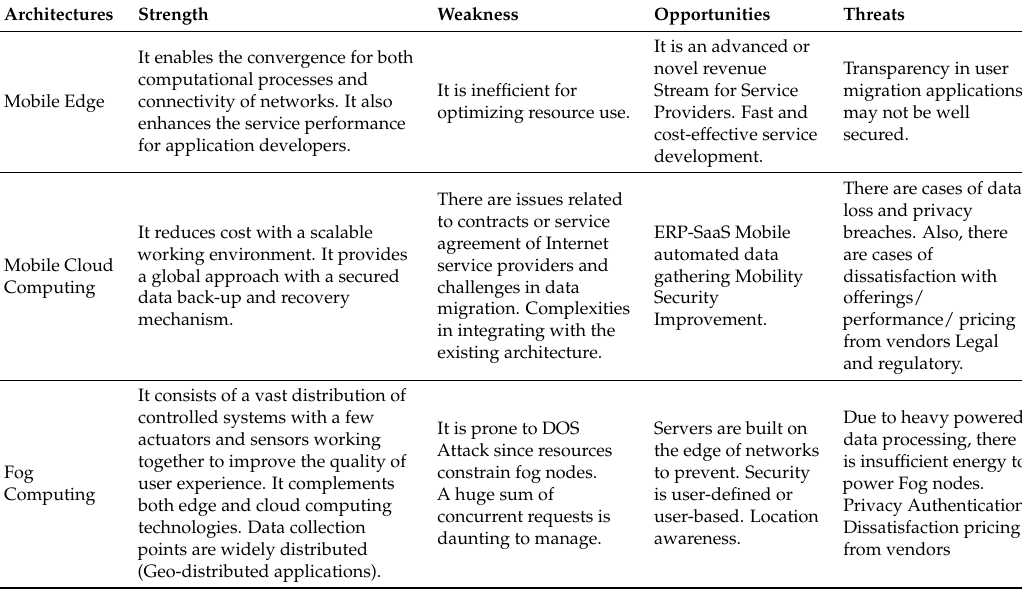
Table 2. A brief SWOT analysis of Cloud, Edge and Fog